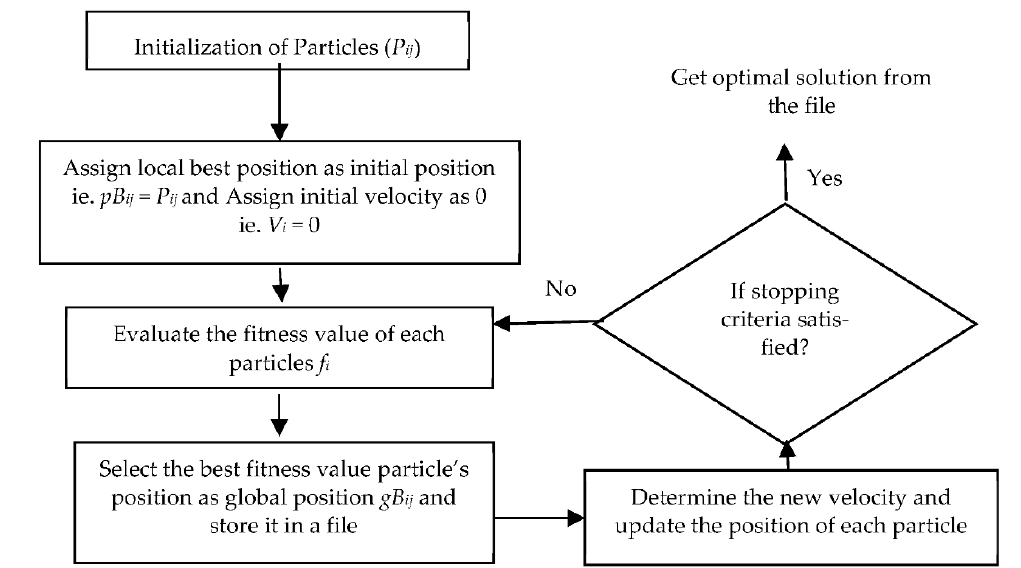
Figure 14. Implementation of PSO algorithm.